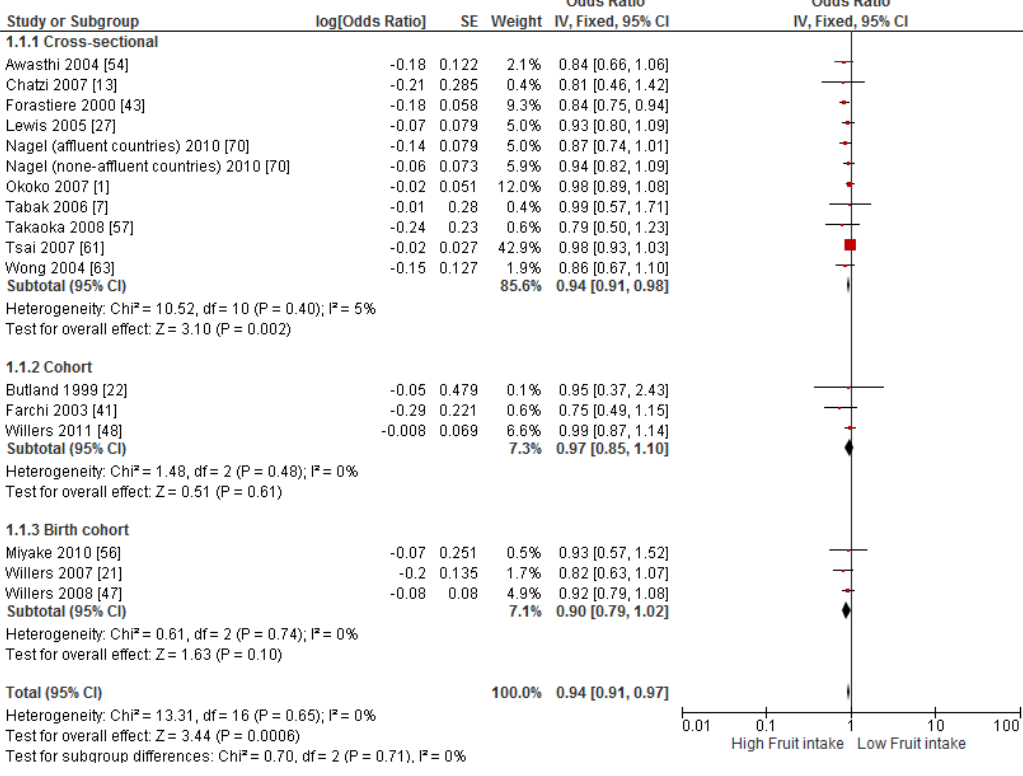
Figure 7. Meta ‐ analysis of the association between fruit intake and risk of prevalent wheeze. Figure 7. Meta-analysis of the association between fruit intake and risk of prevalent wheeze. Nutrients 2017 , 9 , 341